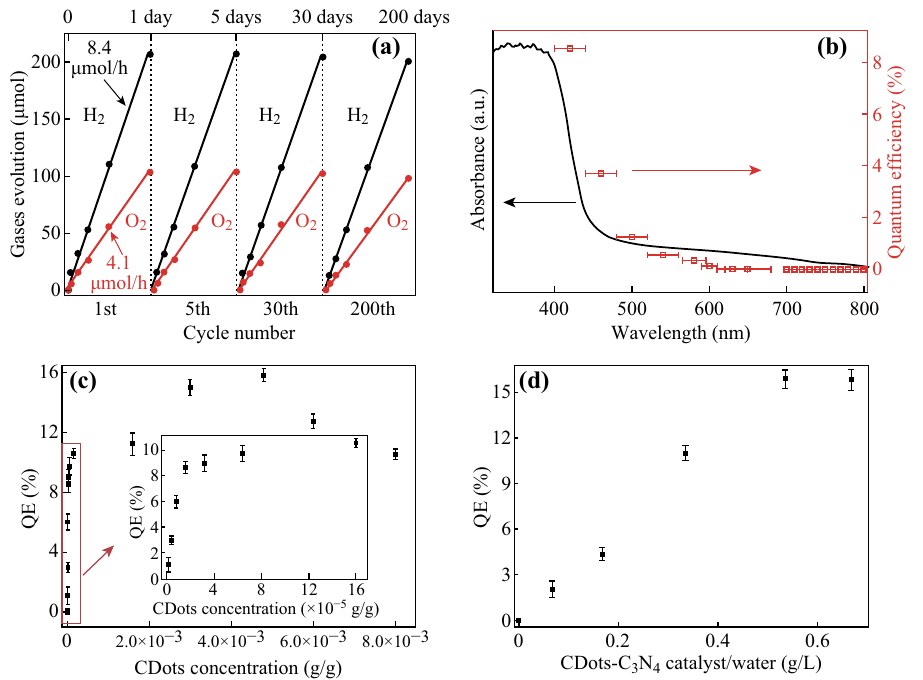
Fig. 8 a Typical H 2 and O 2 production from water under visible-light irradiation. b Wavelength-dependent QE ( red dots ) of water splitting by composite catalyst. c QE for different concentrations of carbon dots/g-C 3 N 4 catalysts in a fixed mass of composite catalyst. d QE for different catalyst loads with a constant carbon dot concentration in 150 ml of ultra-pure water. Reproduced with permission from Ref. [95]. Copyright 2015 American Association for the Advancement of Science. (Color figure